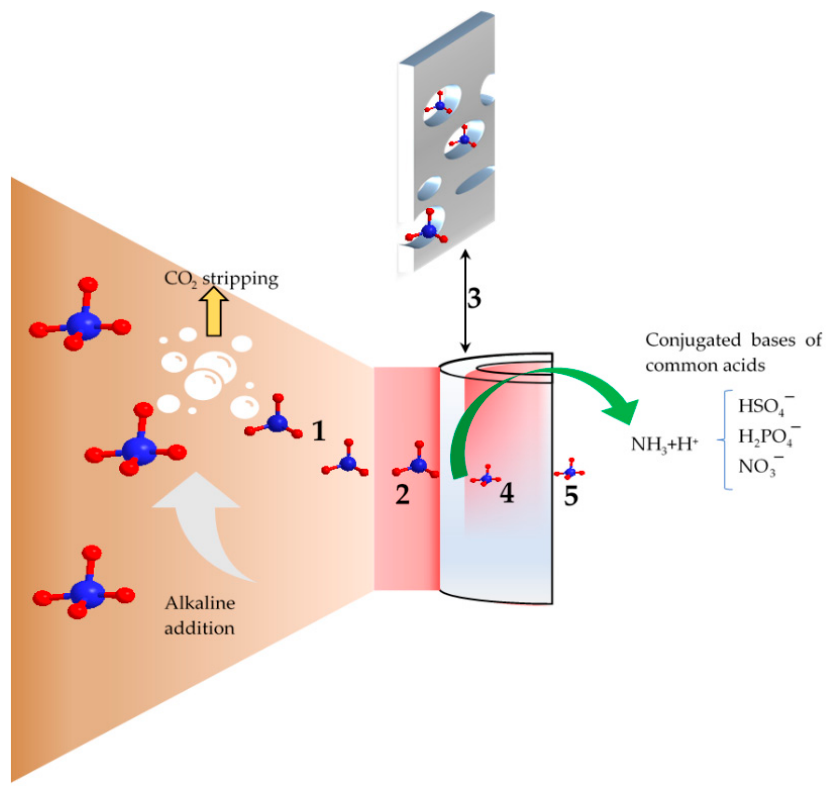
Figure 13. Ammonia recovery principle in membrane contactor. Table 8. Summary of recent studies of nitrogen recovery with membrane contactor.